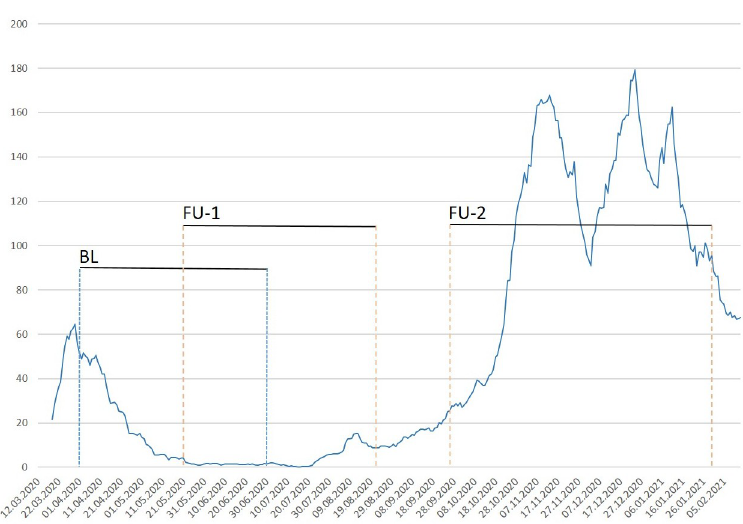
Fig 4. Incidence of SARS-CoV-2 infections at the city of Hamburg during the study. The local incidence of SARS CoV-2 slowly decreases druring the baseline period between 2th April to 30th June and remaind on a low level, when FU-1 was conducted. At the beginning of FU-2, a rapid increase was found with a maximum incidence rate on 24th December 2020. Y-Axis: 7-day incidence rate per 100.000 citizens of Hamburg; BL, baseline; FU-1, first follow-up visit; FU-2, second follow-up visit. Data adapted from: https://www.hamburg.de/corona-zahlen; accessed 14th June